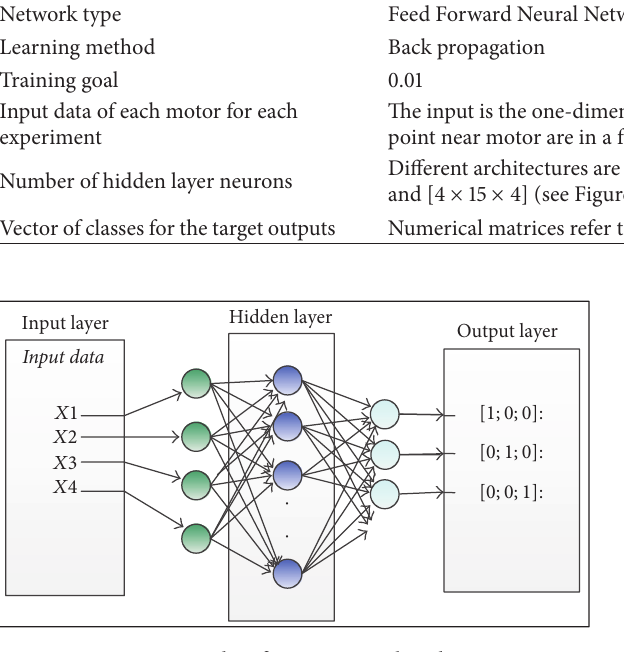
Figure 7: ANN classification network architecture.